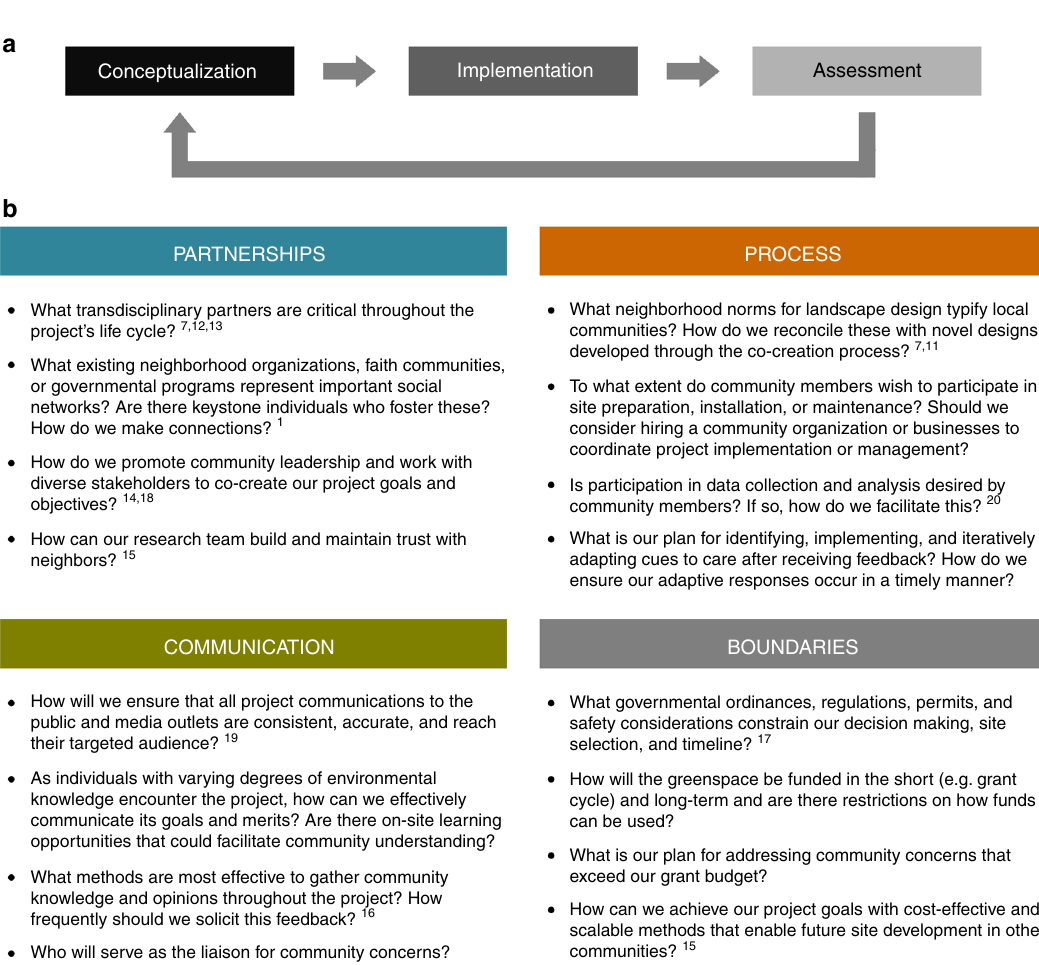
Fig. 2 Guiding questions for ecologists planning future urban greening projects. A “ for the city ” paradigm for ecological research approaches urban conservation as an iterative community development process ( a ) for the bene fi t of urban residents and taxa of interest. Applying such frameworks can be dif fi cult for scientists with disciplinary knowledge but little expertise working with a diverse set of stakeholders. We recognize that praxis often falls short of aspirational theory and provide the following set of questions and references ( b ) for consideration by practitioners embarking on new projects 1,7,11 – 20 . As urban conservation is complicated and context dependent, this is not an exhaustive list and references often apply to multiple questions. Moreover, we emphasize that both community development and urban conservation are long-term endeavors, not activities bounded by a research grant, and that iterative adaptions are critical to achieving positive